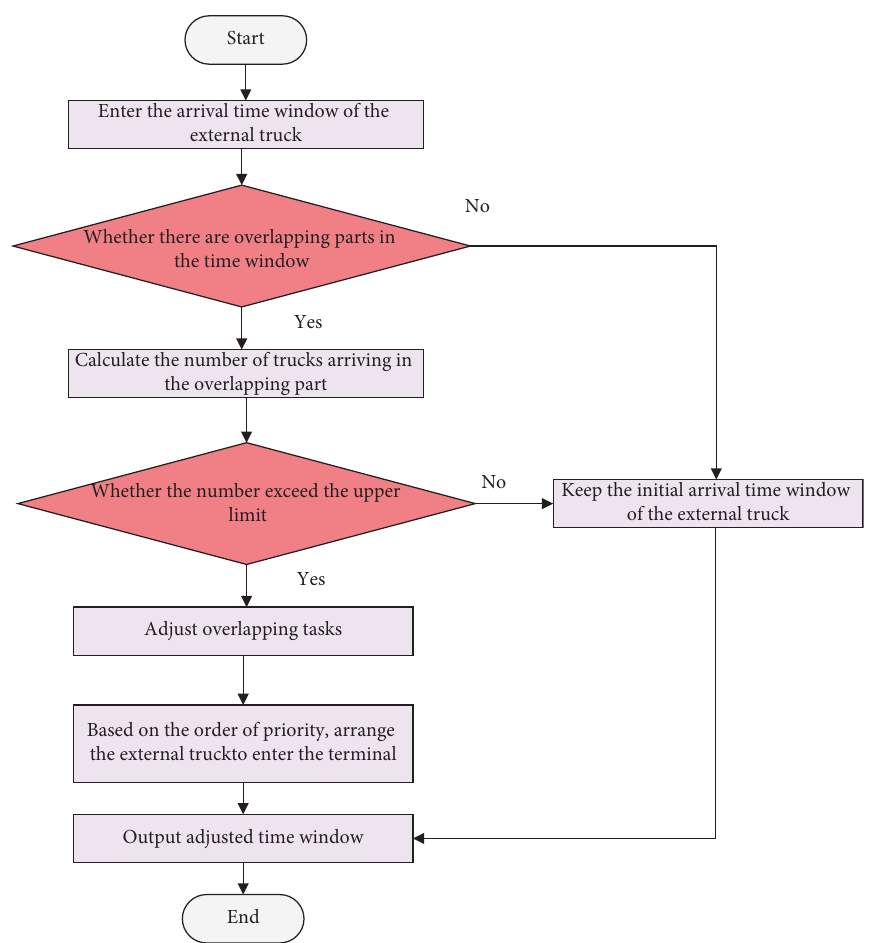
Figure 3: The details of the lower-level